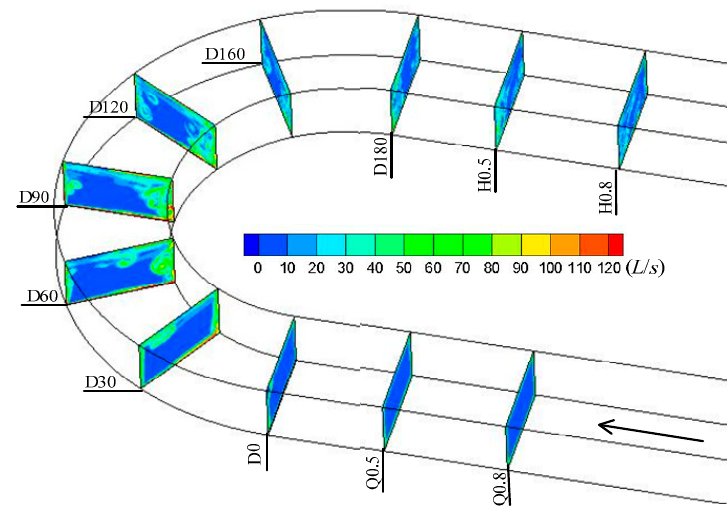
Figure 14. Vorticity diagram along the cross section.